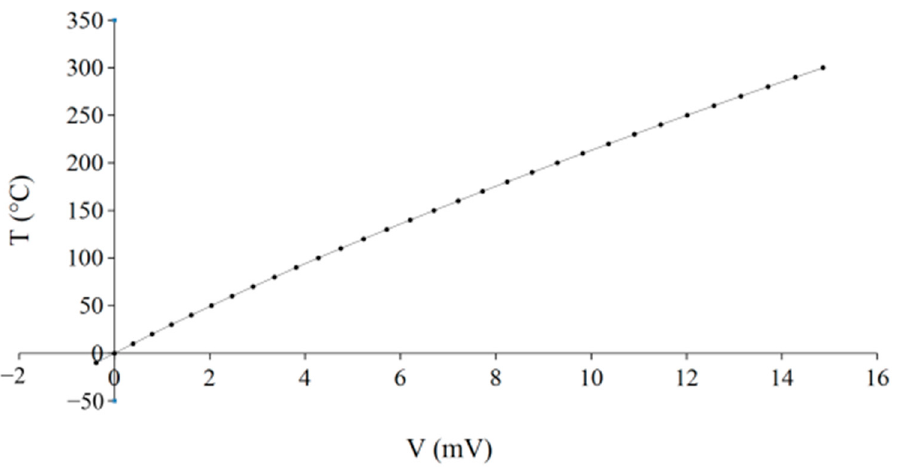
Figure 5. Plot of temperature T vs. thermocouple voltage V for a Type T copper–Constantan thermocouple with a water-ice reference junction. A polynomial least squares fit of the data yields the coefficients in the power series expansion.